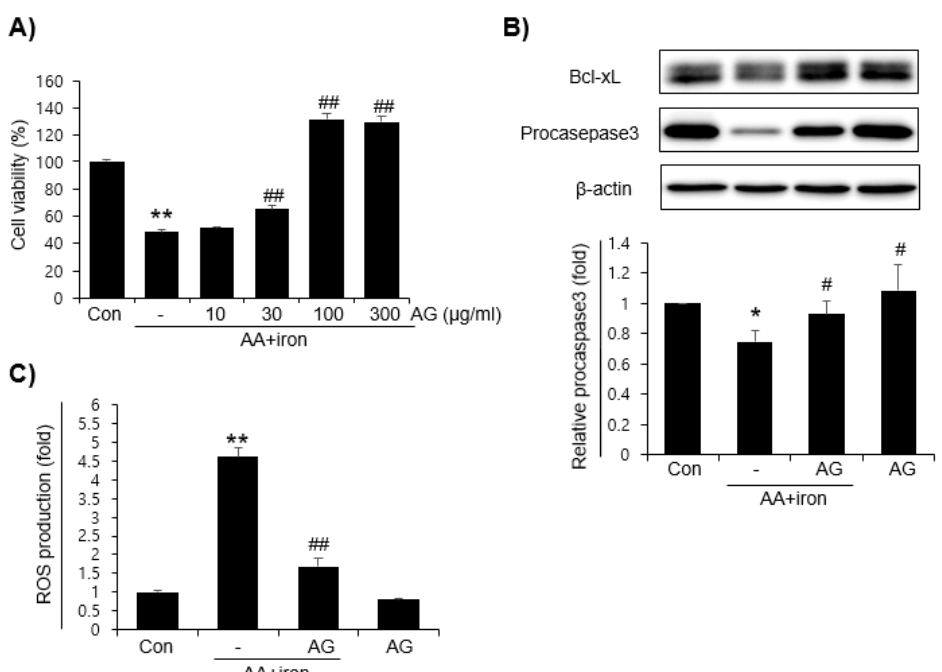
Figure 1. Effect of AG on arachidonic acid (AA)+iron-induced cytotoxicity in HepG2 cells ( A ) Cell viability was assessed by the MTT assay. HepG2 cells were pretreated with AG (10, 30, 100, and 300 µ g/mL) for 1 h. Subsequently, the cells were treated with AA (10 µ M) for 12 h and iron (5 µ M) for 6 h. ( B ) Immunoblot analysis of apoptosis-associated proteins, Bcl-xL and procaspase3. HepG2 cells were treated with AG (100 µ g/mL) for 1 h, AA (10 µ M) for 12 h, and iron (5 µ M) for 1 h. ( C ) ROS production measurements. HepG2 cells were stained for 30min on DCFH-DA (10 µ M) after incubation for 1 h AG (100 µ g/mL), 12 h AA (10 µ M) and 1 h iron (5 µ M). All data represent means ± SD of three independent experiments (* p < 0.05 and ** p < 0.01 vs. control group; # p < 0.05 and ## p < 0.01 vs. AA+iron-treated group). AA, arachidonic acid; AG, Angelica gigas NAKAI